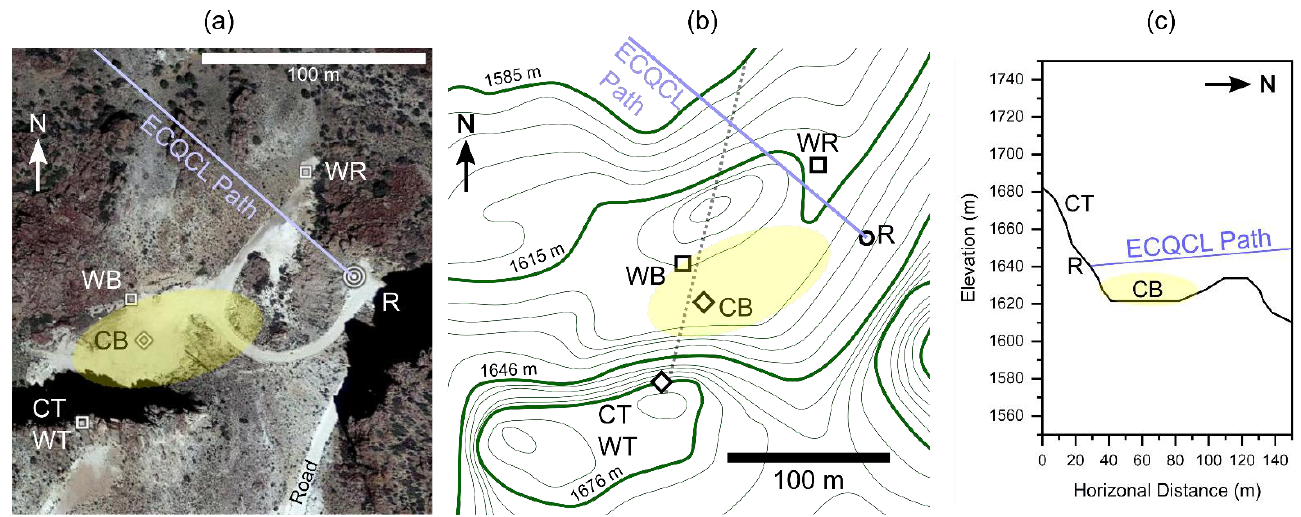
Figure 2. Details of plume release site topography. ( a ) Overhead view obtained from Google Earth imagery. Labels indicate locations of retroreflector (R), plume release sites (CT, CB), and wind sensors (WT, WB, WR). ( b ) Topographic contour map showing elevation profile in release region (contour lines separated by 6 m). ( c ) Elevation profile along the path indicated by dashed grey line in ( b ). The elevations of the release locations (CT, CB) and retroreflector (R) are shown. The shaded yellow region in all panels indicates the presence of a local depressed area of elevation in which plumes could become partially trapped.